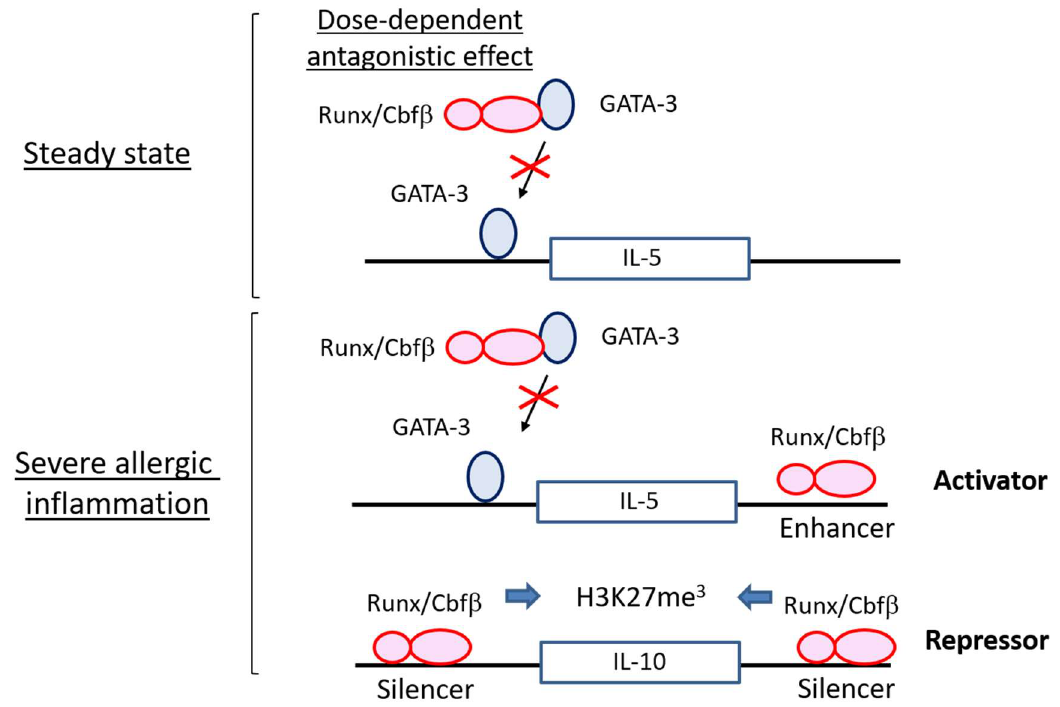
Figure 3. Transcriptional regulation by Runx/Cbf β complexes in ILC2s. Runx/Cbf β complexes antagonize GATA-3 (red cross) and suppress the ILC2 activity irrespective of allergic inflammation in a dose dependent manner. The presence of Runx/Cbf β complexes is indispensable for ILC2s not to acquire a gene expression profile of exhausted-like ILC2s. Runx/Cbf β complexes function as activators for gene expression of ILC2 cytokines and receptors, and as repressors for inhibitory molecules, such as IL-10.